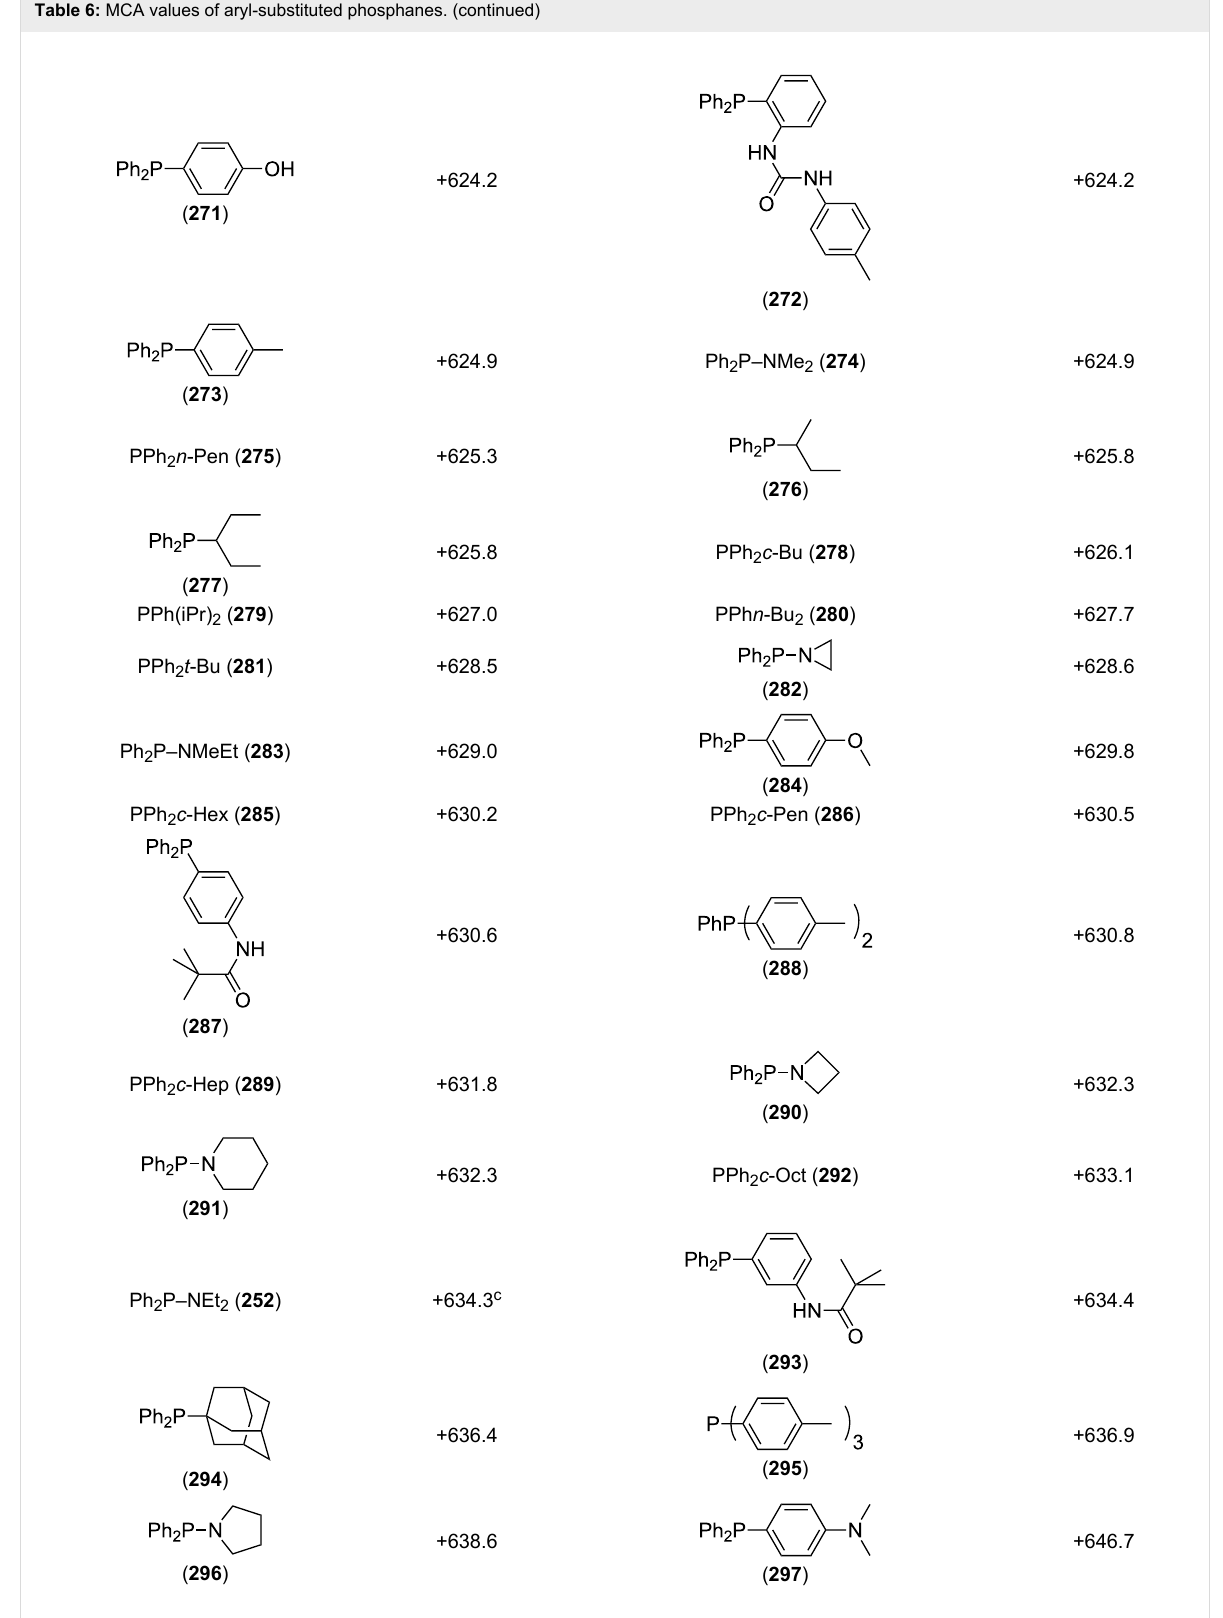
Table 6: MCA values of aryl-substituted phosphanes.